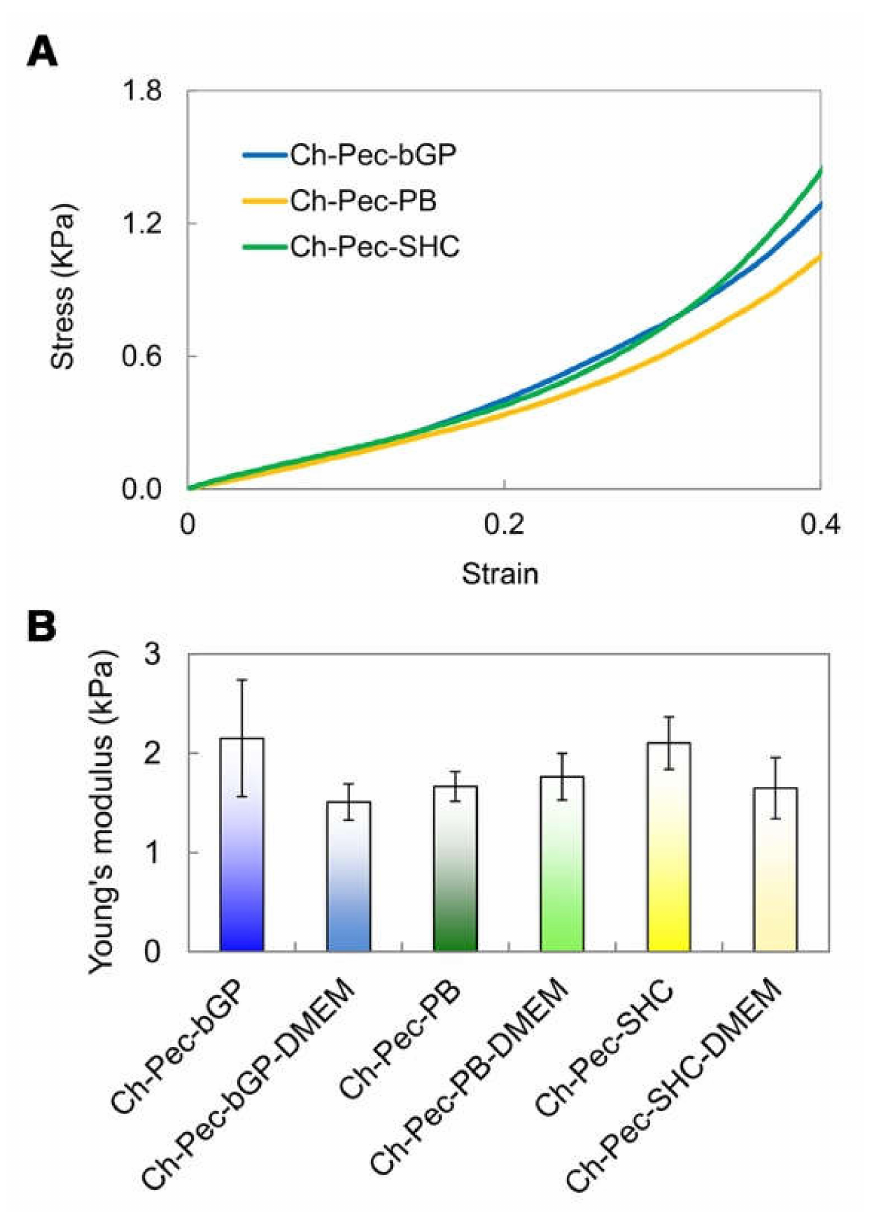
Figure 8. Compression test: ( A ) Stress–strain curves of the hydrogel formulations ( β GP-PB-SHC). ( B ) Average values of Young’s modulus for all three hydrogels with and without DMEM (n =